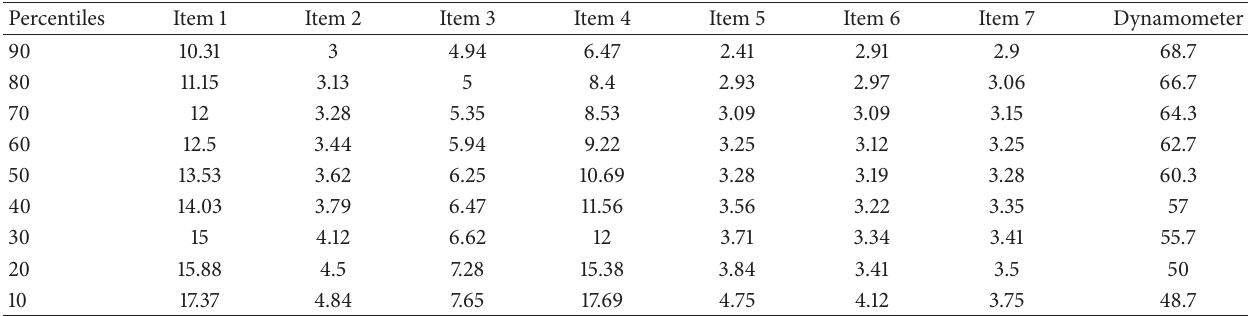
Table 18: 𝑛 = 19 , males, 6–19, dominant hand, educational instruction: elementary school.